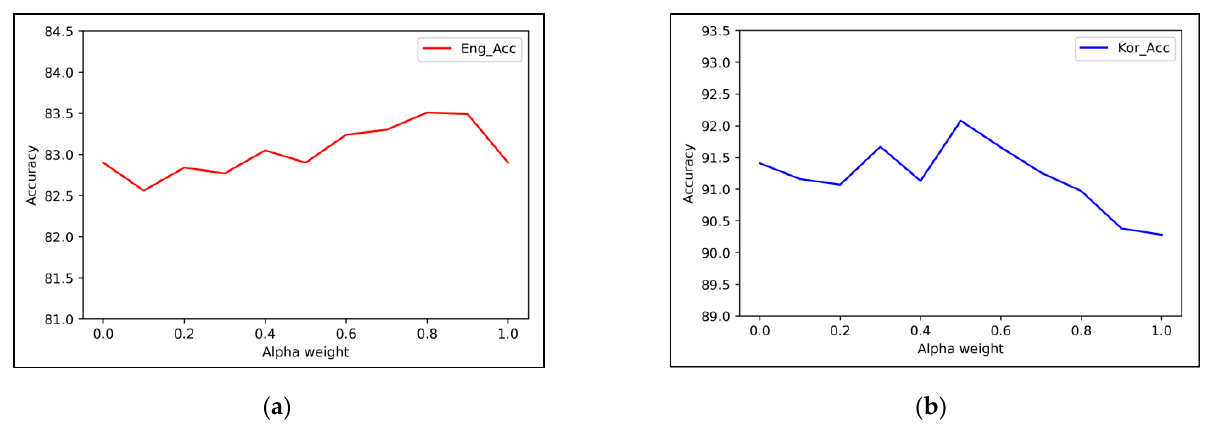
Figure 2. ( a ) English dataset accuracy according to α ; ( b ) Korean dataset accuracy according to α .